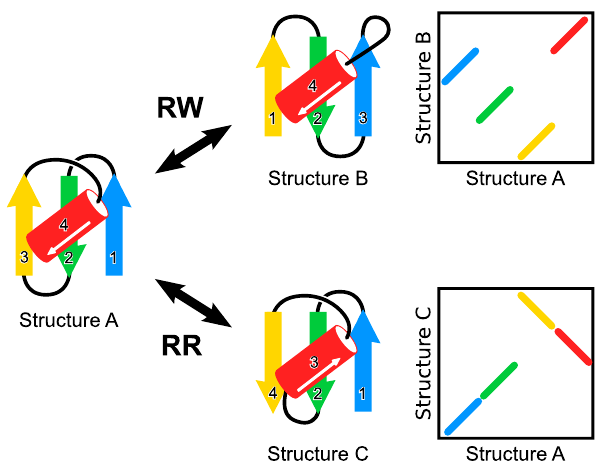
Figure 1. Schematic examples of structure alignment by the RW and RR alignment schemes. The protein structure is shown as a schematic model. Structures A and B were aligned by the RW scheme, and structures A and C were aligned by the RR scheme. The corresponding alignment plots are shown on the right hand side of